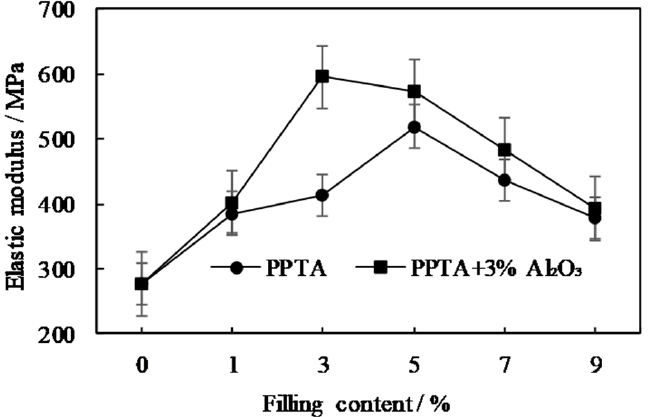
Figure 19. Elastic modulus of PPTA and nano Al 2 O 3 filled modified PTFE composite.